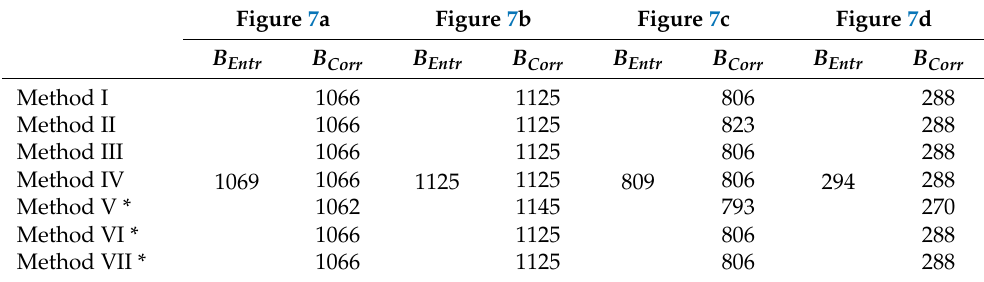
Table 6. B Entr input data and the determined B Corr values for the adopted criterion of maximizing the value of the calculated measure for the example images shown in Figure